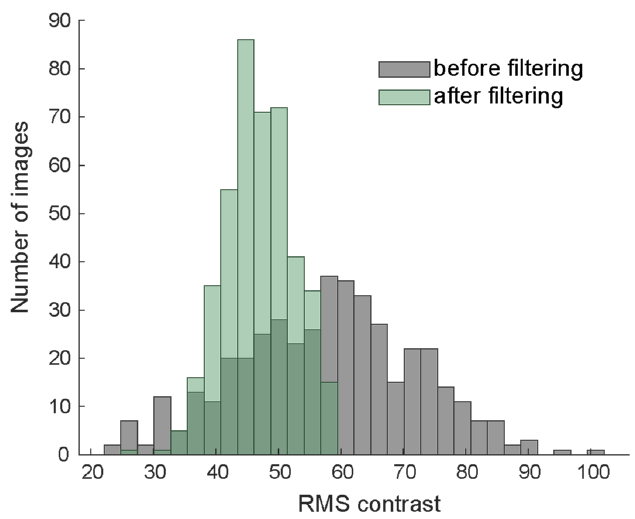
Figure 2. Distribution of root-mean-squared contrast before (gray) and after (green) filtering and contrast normalization.